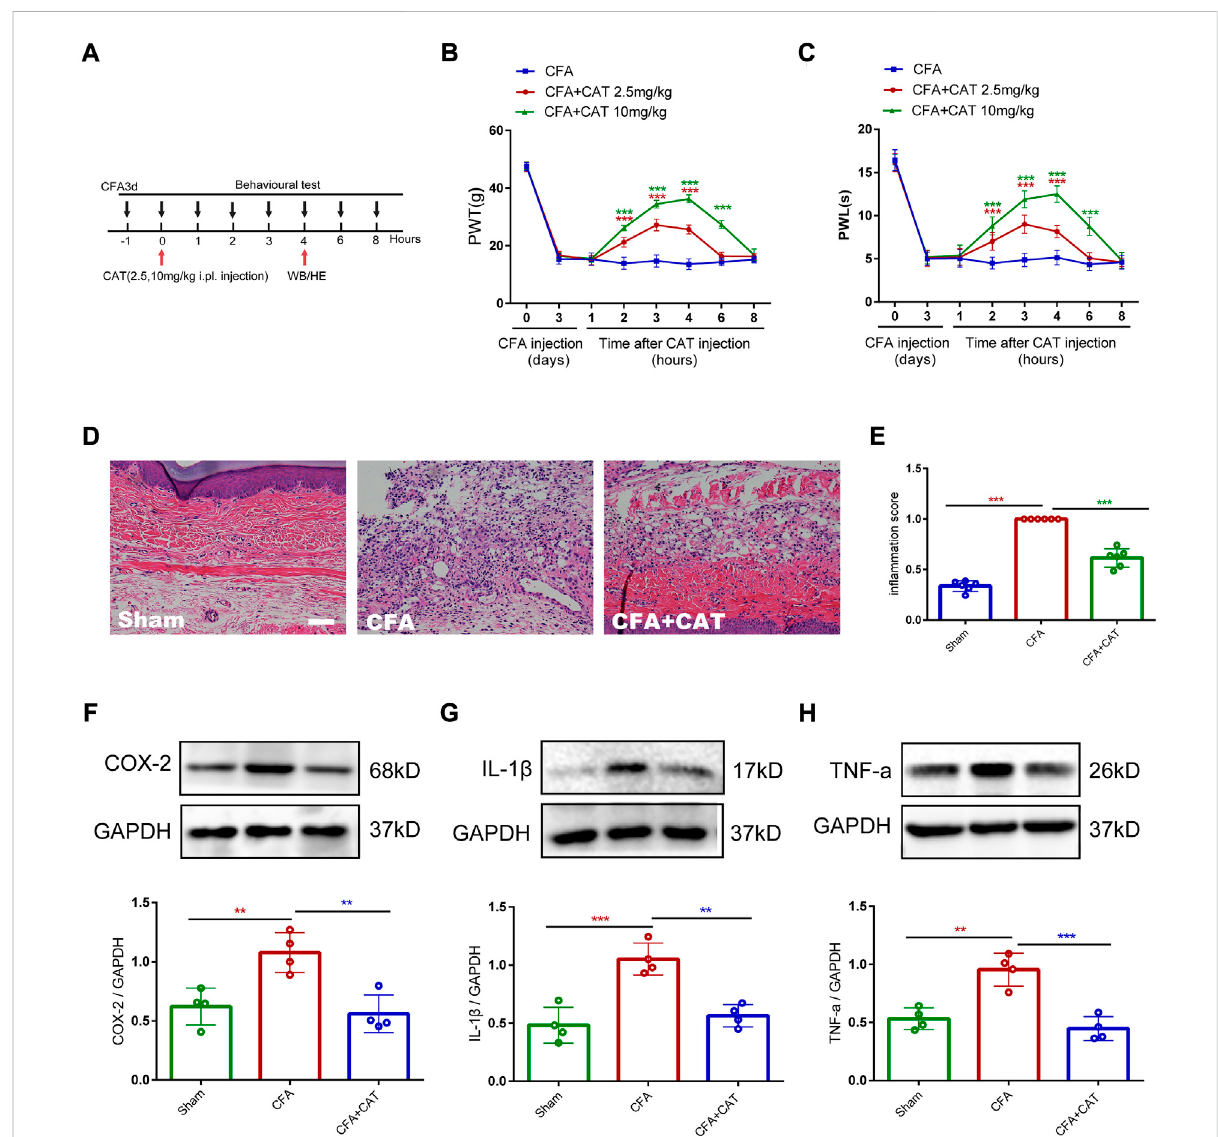
FIGURE 7 Catalpol reduces peripheral pain by inhibiting tissue in fl ammation. (A). Timeline for single subcutaneous injections of catalpol. (B,C). Effect of single subcutaneous injections of Catalpol (2.5 mg/kg and 10 mg/kg) on PWT and PWL. (*** p < 0.001 vs. the CFA group; n = 6, two-way repeated measures ANOVA). (D,E). H&E staining of paw skin in different groups. ( ppp p < 0.001 vs. the CFA group; n = 4, one-way ANOVA). Scale bar = 50 μ m. (F – H). The protein expression of COX-2, IL-1 β and TNF-a in the paw skin of rats were detected by Western blotting. (** p < 0.01 and ppp p < 0.001 vs. the CFA group; n = 4, one-way